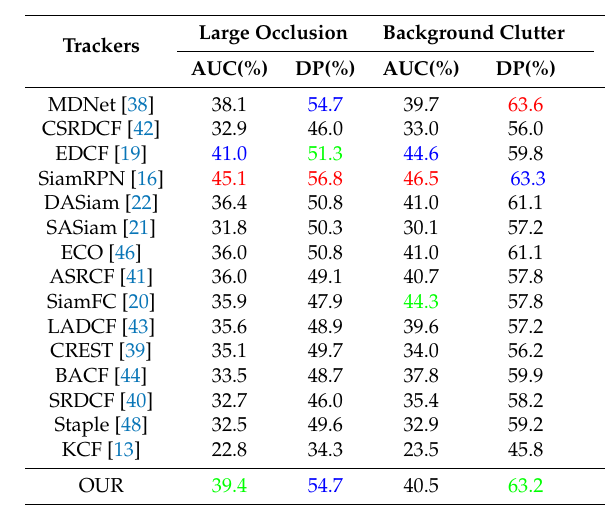
Figure 9. Success plots based on tracking results on the UAVDT [7] dataset in nine sequence attributes, including: background clutter (29), camera motion (30), object motion (32), small object (23), illumination variations (28), object blur (23), scale variations (29), long-term tracking (6), and large occlusion (20). The legend of overlap success is the area-under-the-curve score. The proposed algorithm performs well against state-of-the-art results. Table 2. Performance comparison of different trackers under large occlusion and background clutter conditions. The distance precision (DP) is threshold scores at 20 pixels. The AUC is the area under the success rate curve score. The red, blue, and green colors represent the first, second, and third